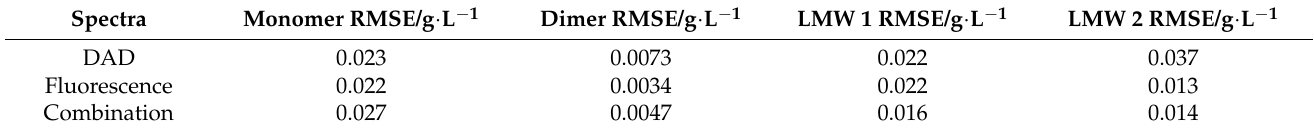
Table 2. Root-mean-square error of validation (RMSE) for different product contents and PLS models. Spectra